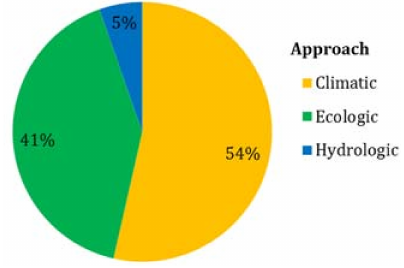
Figure 7. Dendrochronological studies performed in Mexico and grouped by its scope of application. The journals in which the greatest numbers of Mexican dendrochronological studies have been published are mostly national journals covering 40% of the studies, such as: Madera y Bosques ( n = 9 studies), Revista Chapingo-Serie Ciencias Forestales y del Ambiente ( n = 5 studies), Agrociencia ( n = 4 studies). This is followed by international journals, such as Dendrochronologia or Tree-Ring Research,